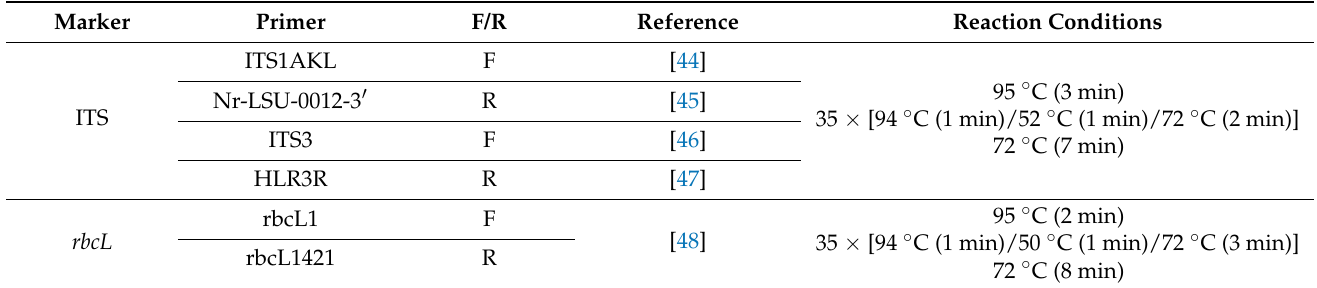
Table 2. Primers used for amplification and sequencing with PCR reaction conditions. Reference Reaction Conditions